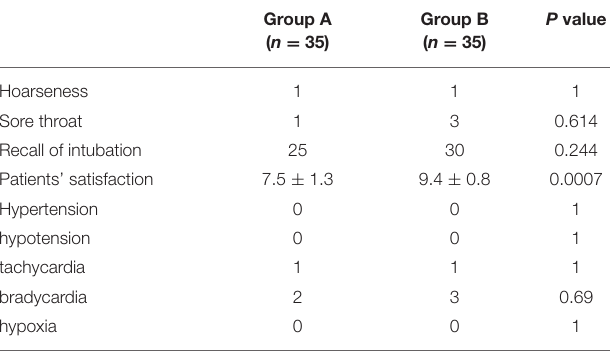
TABLE 3 | Postoperative visit data and advent